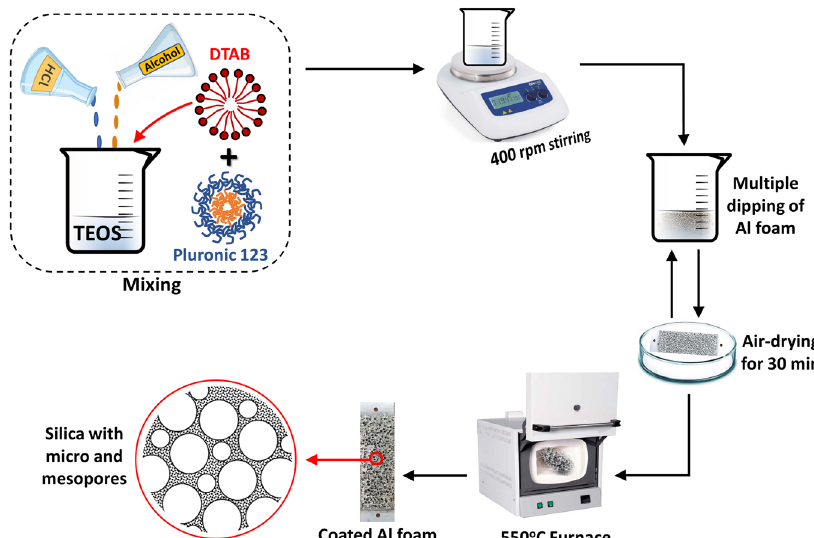
Fig. 10 Synthesis procedure of the Al foam coated sorption bed. Steps followed for preparing the developed, tuned silica and coating aluminum foam.